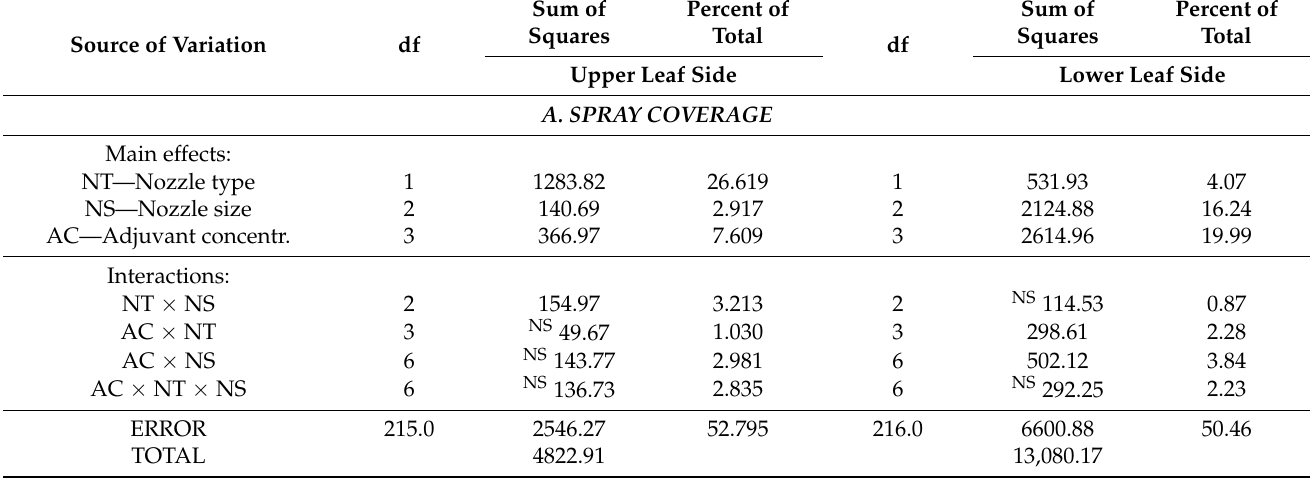
Table 4. The ANOVA summary table for data sets of spray coverage (A) and droplet density (B) on upper and lower surfaces of apple leaves obtained during the treatments with adjuvant Silwet L-77. The denotation NS marks not significant effects or interactions at p <